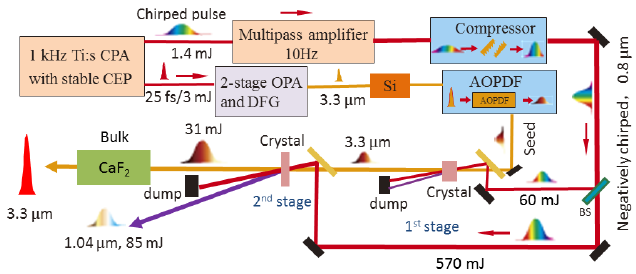
Fig. 1. Schematic of the experimental setup.